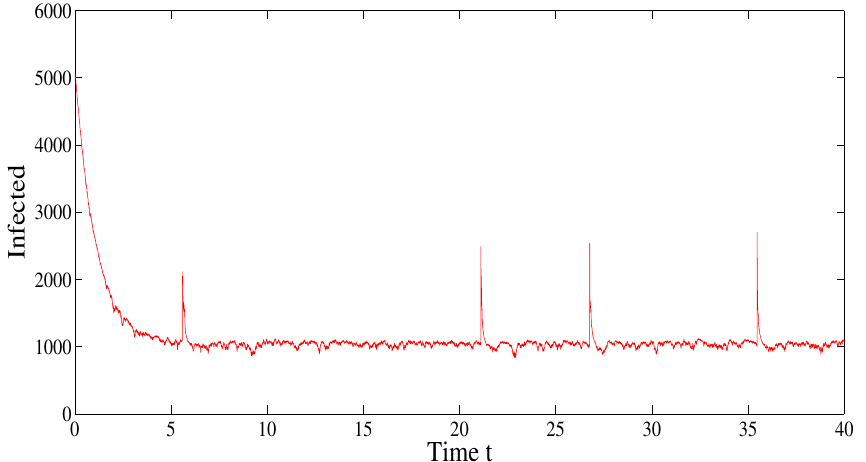
Figure 5. The infected population as a function of time when λ = 100, µ = 0.0013, β = 0.1, γ 2 = 1, γ 1 = 0.1, (cid:101) = 0.33, δ = 0.09 and d =